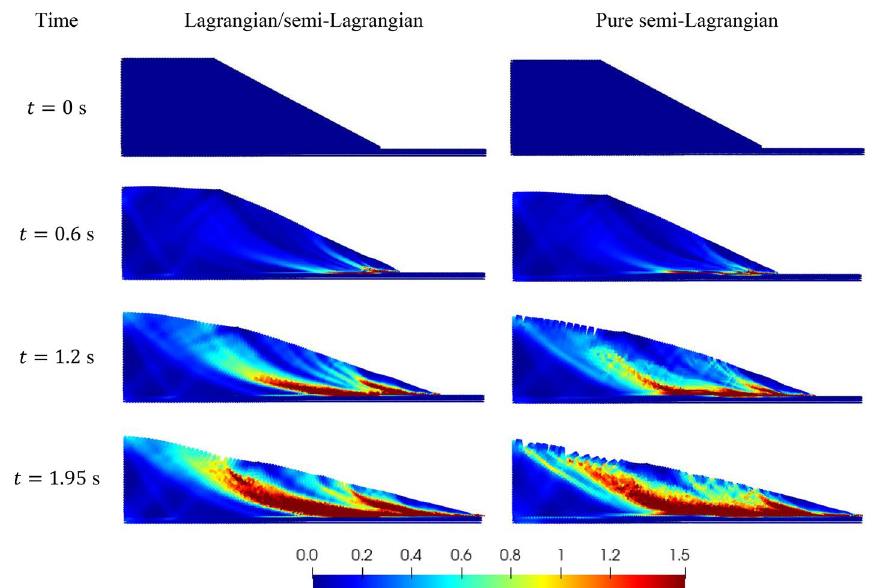
Fig. 21 Progressive levee failure plotting equivalent plastic strain: coupled Lagrangian/semi‑Lagrangian (left) and pure semi‑Lagrangian (right)